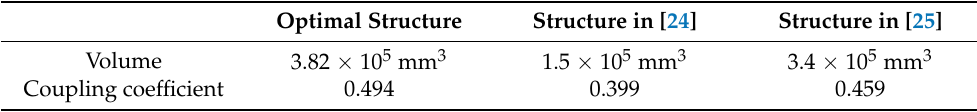
Table 8. Performance comparison for different structure